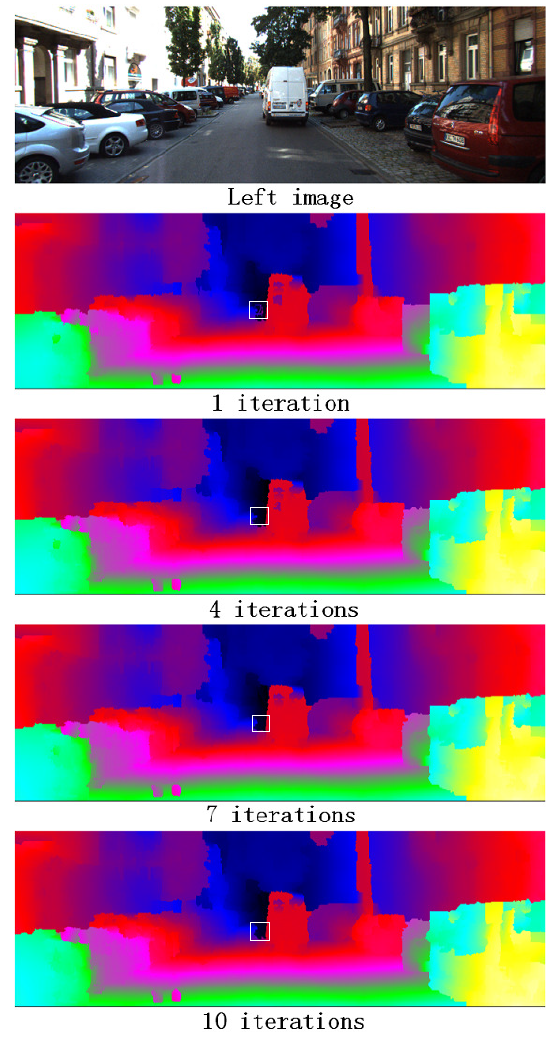
Figure 6. The disparity maps in different iteration